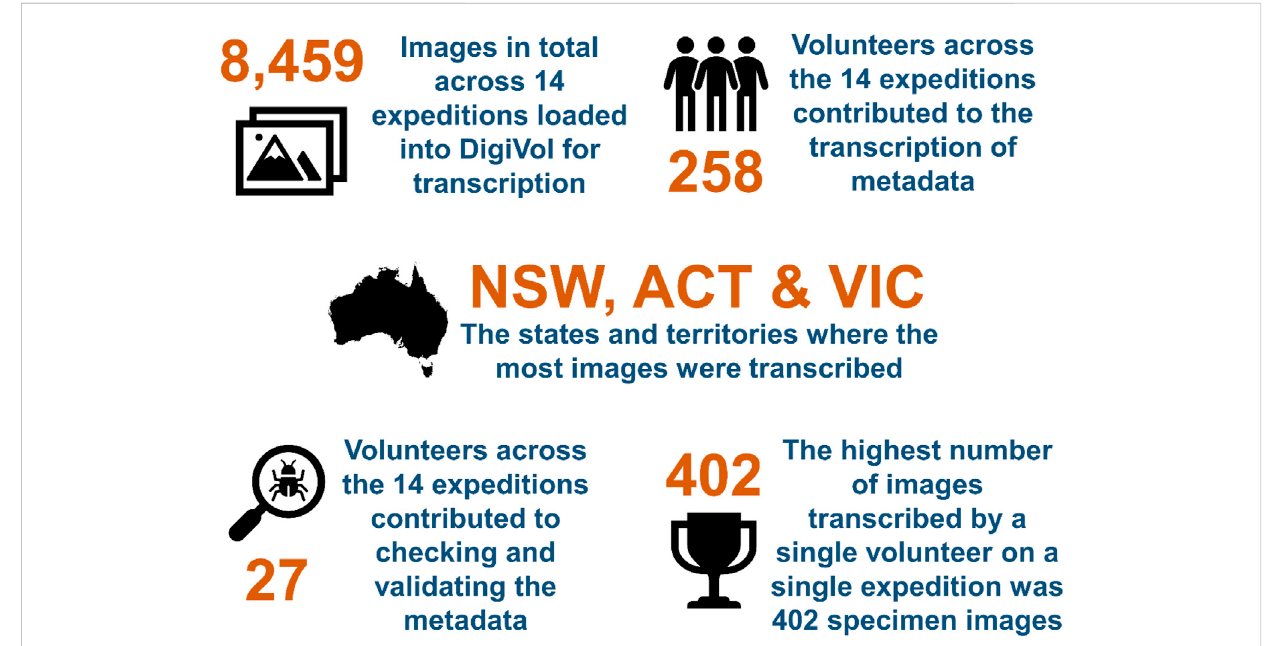
Insect digitisation project statistics on the DigiVol platform where volunteers transcribed specimen